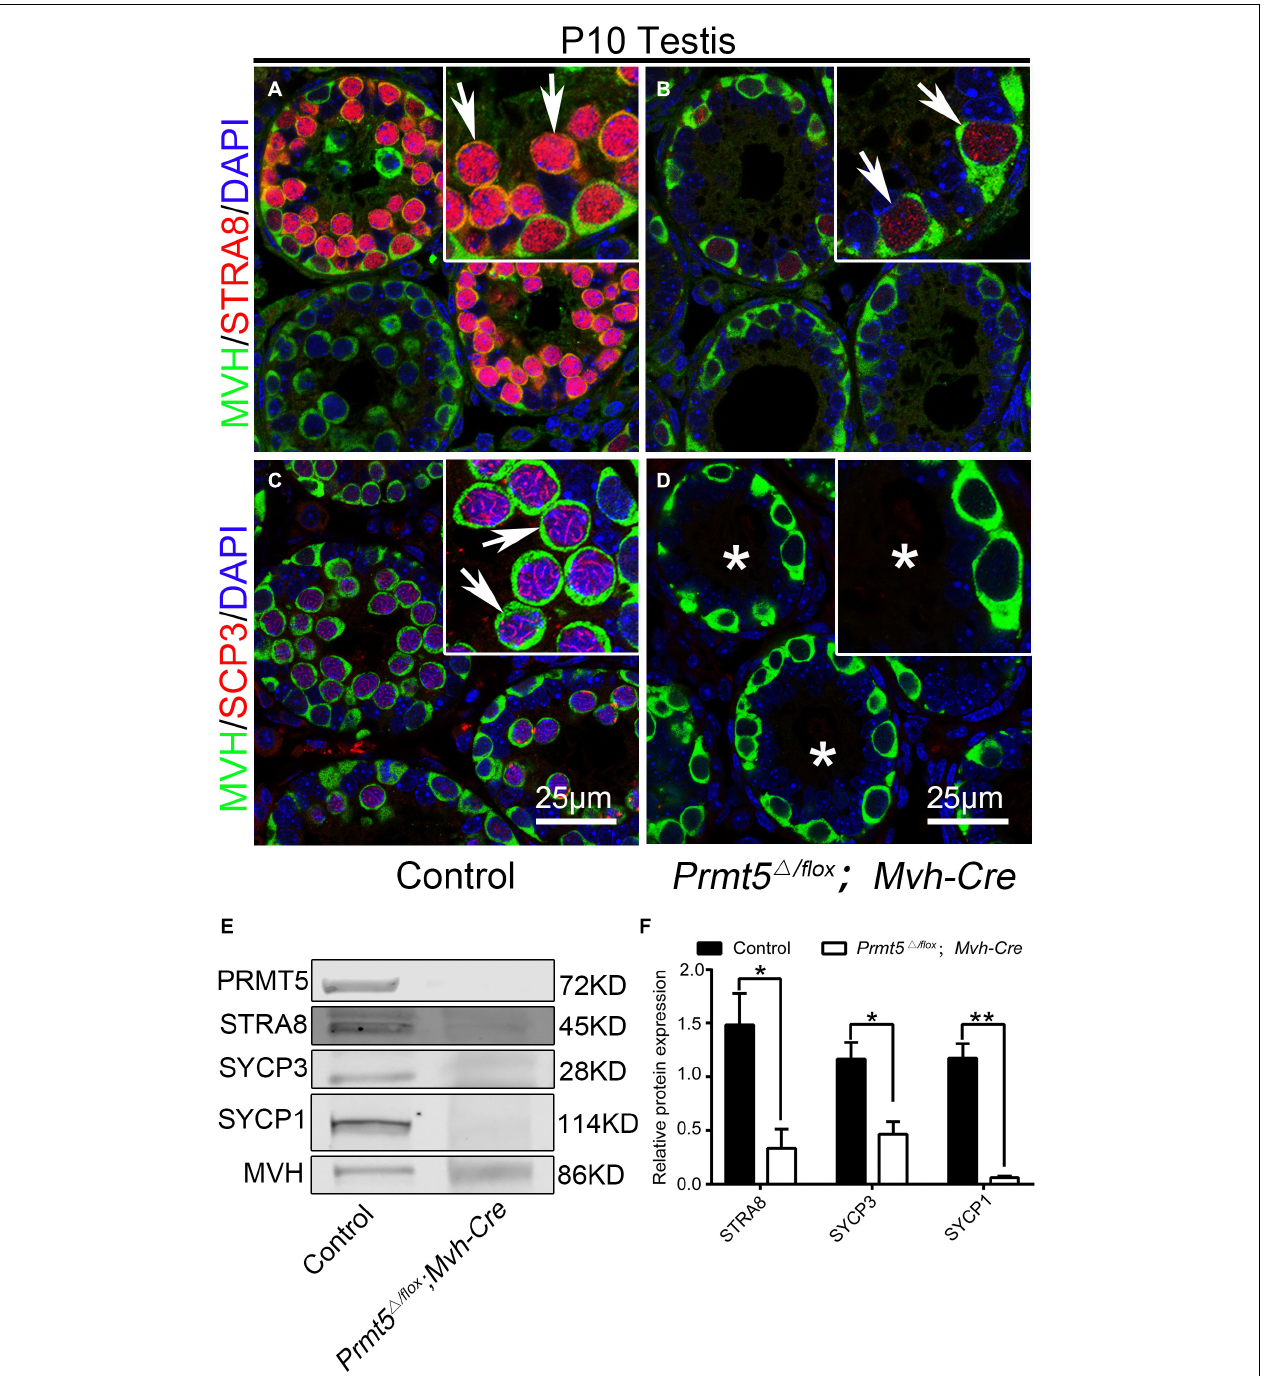
FIGURE 3 | Prmt5 -deficient germ cells exhibit a defect in meiosis initiation. A strong STRA8 signal was detected in the germ cells of control testes [ (A) , white arrows], whereas only a weak STRA8 signal was detected in the germ cells of Prmt5 (cid:49)/ flox ;Mvh-Cre testes [ (B) , white arrows]. SYCP3-positive germ cells were observed in control testes [ (C) , white arrows], but no SYCP3 signal was detected in the germ cells of Prmt5 (cid:49)/ flox ;Mvh-Cre testes [ (D) , asterisks]. The expression of meiosis-associated genes (STRA8, SYCP3 and SYCP1) was significantly reduced in Prmt5 (cid:49)/ flox ;Mvh-Cre testes at P10 (E,F) , The total protein detected from control testes was 10 µ g, and the total protein detected from Prmt5 (cid:49)/ flox ;Mvh-Cre testes was 40 µ g. MVH was used as a loading control in (E) , protein values were normalized to MVH and expressed as the mean ± SEM ( n = 3), * P < 0.01, ** P < 0.001 indicates a significant difference ( t -test).